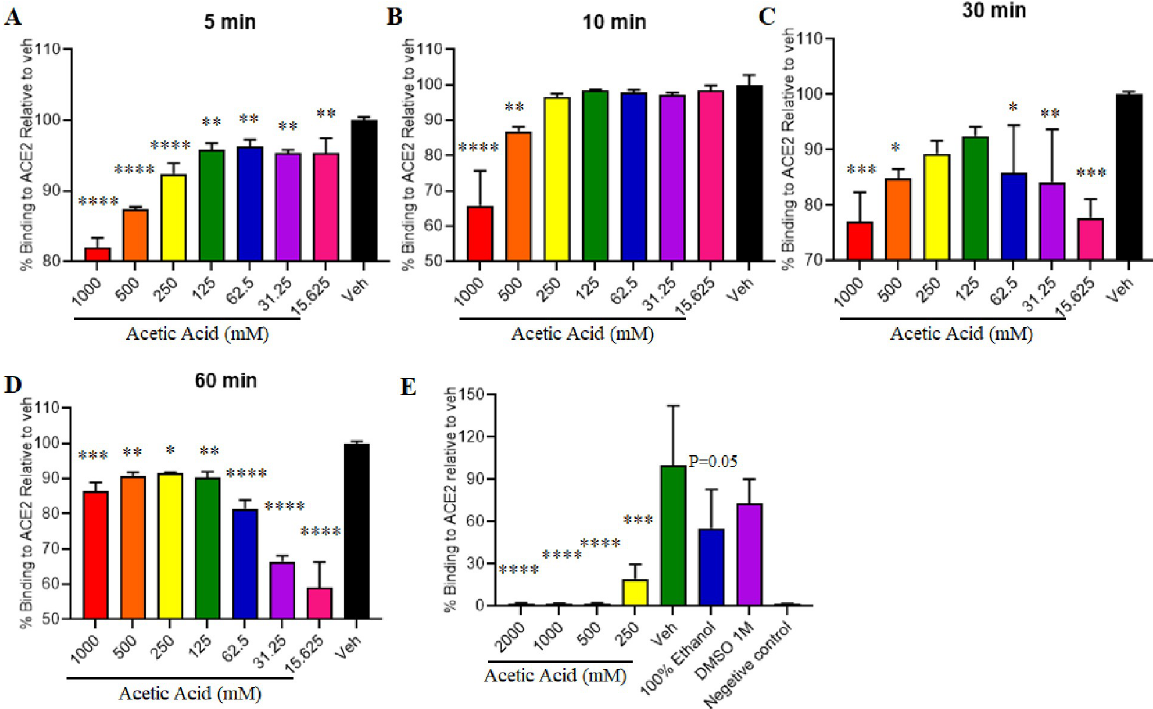
Fig 3. Acetic acid effects on SARS-CoV-2 spike and ACE2 binding. Enzyme-linked immunosorbent assay data indicates that Acetic Acid or Vinegar (Acetic Acid at 1M, or at 2 M) alters binding of Spike to human angiotensin-converting enzyme (ACE2). (A-D) When spike-coated plates are incubated with concentrations of Acetic Acid and the effect of Acetic acid was tested when in contact with spike protein for (A) 5 minutes; (B) 10 minutes; (C) 30 minutes; (D) 60 minutes; as well as (E) when ACE2 coated plates are incubated with Spike RBD protein and different concentrations of Acetic Acid was tested when in contact with spike protein for 30 minutes. Data was normalized to no-Acetic Acid vehicle control (stats as compared to respective vehicle). Data represent mean ± SD, n = 3 � p < 0.05; �� p < 0.01; ��� p < 0.001; ���� p < 0.0001.